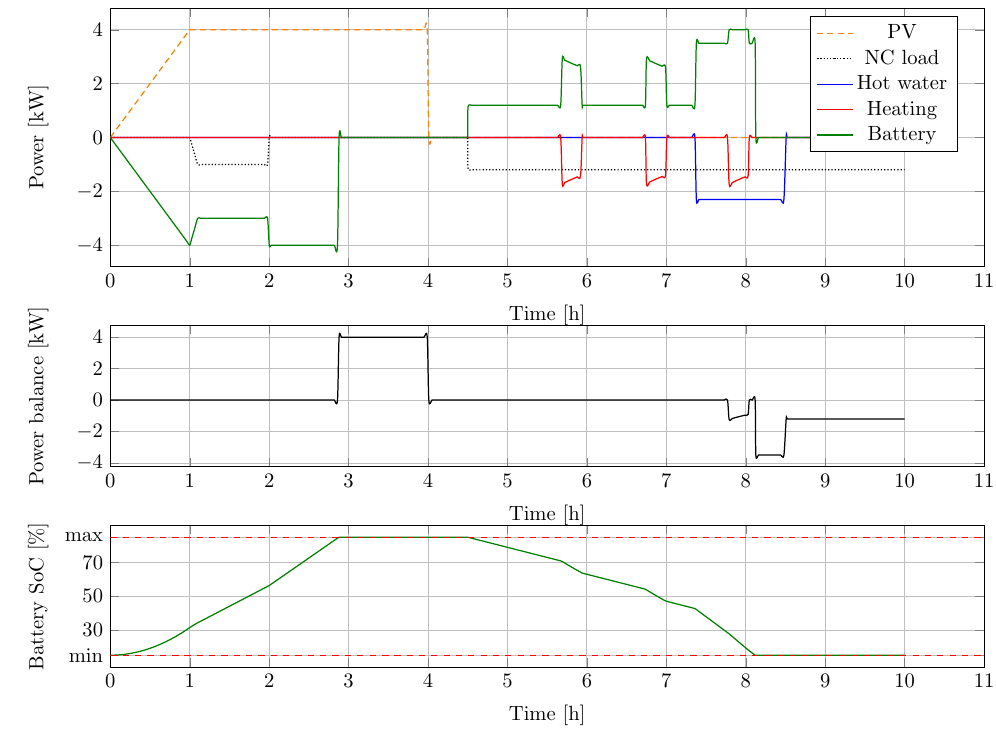
Figure 2. Power of the devices for the verification